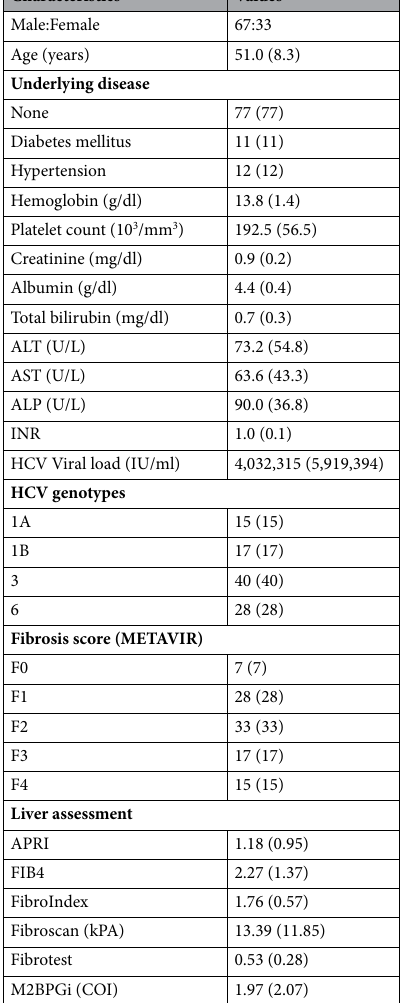
Table 1. Baseline characteristics of the 100 HCV patients. Data are expressed as mean (standard deviation) or number (%). ALT = alanine aminotransferase, AST = aspartate aminotransferase, ALP = alkaline phosphatase, INR = international normalized